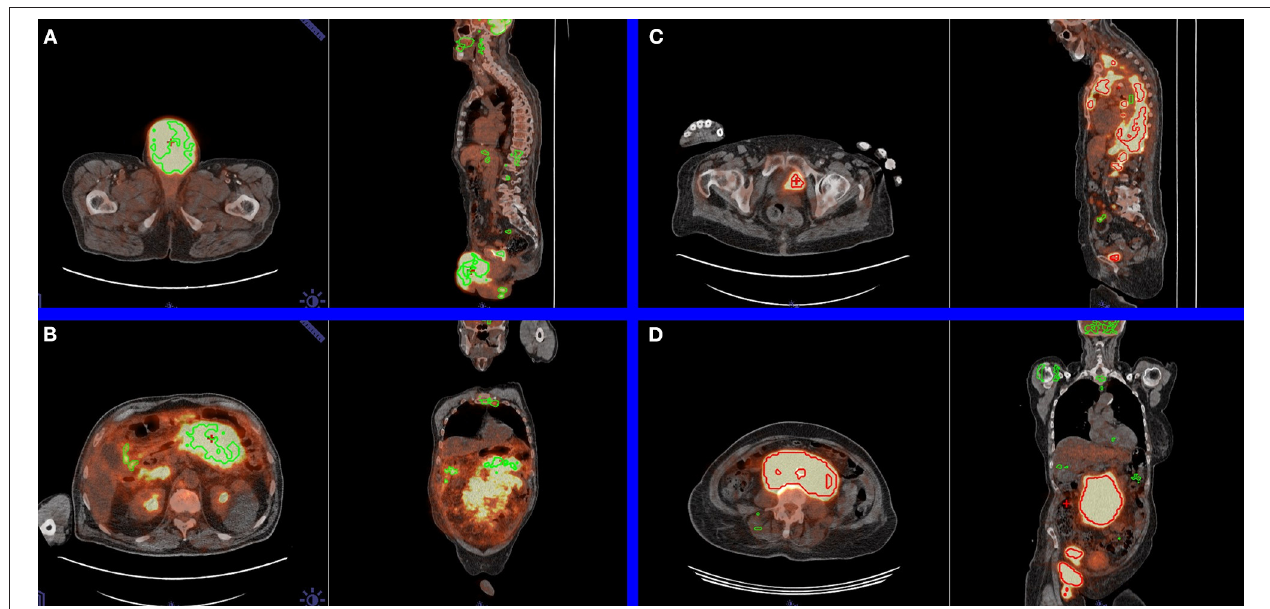
FIGURE 4 | Examples in axial and sagittal views of limitations of the automatic segmentation. (A) Pathological testicular mass labeled as physiological by positron emission tomography Assisted Reporting System (PARS) (false negative). For this patient, the manually and automatically obtained total metabolic tumor volumes (TMTVs) were 281.18 and 5.18ml, respectively. (B) Pathological mesenteric mass was erroneously labeled as physiological by PARS (false negative). For this patient, the manually and automatically obtained TMTVs were 2,125.38 and 89.35ml, respectively. (C) Physiological urinary bladder focus was erroneously labeled as pathological by PARS (false positive). For this patient, the manually and automatically obtained TMTVs were 816.94 and 661.08ml, respectively. (D) Pathological mesenteric mass was correctly labeled as pathological by PARS (true positive). For this patient, the manually and automatically obtained TMTVs were 1,369.19 and 1,343.88ml,